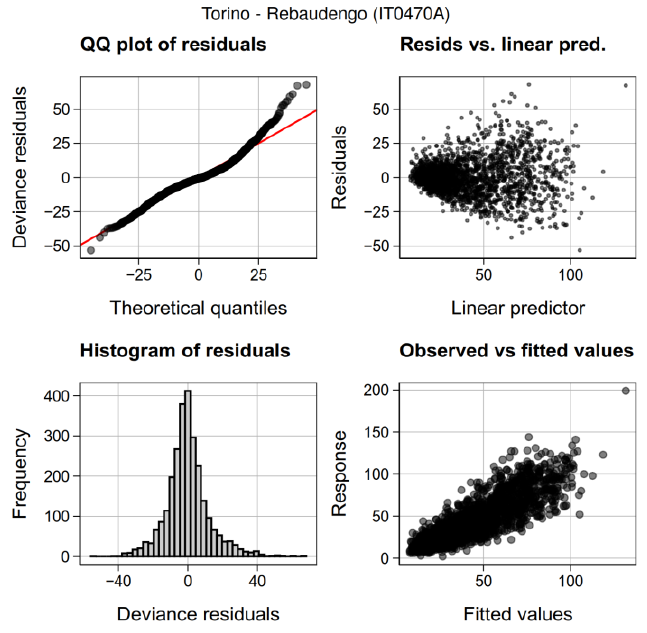
Figure 2. Check of the basic assumptions: residual analysis of the PM 10 model developed for the air quality monitoring station.